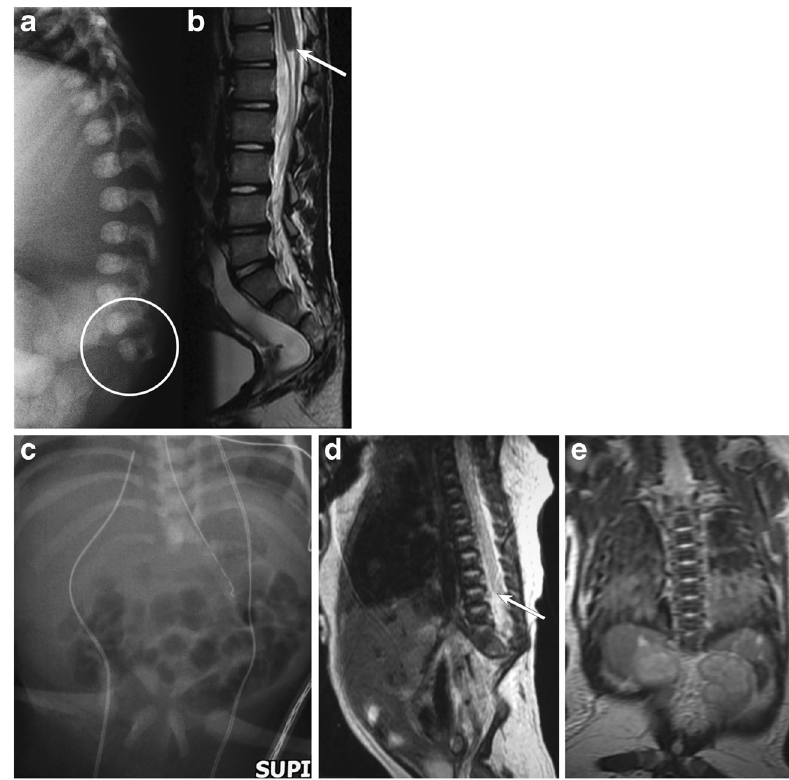
Fig. 3 a - b : Split cord/ diastematomyelia in 15 year old: Axial ( a ) and sagittal T2- weighted ( b ) MR images of the lumbar spine reveals an osseous septum ( thin arrow on a ) dividing the spinal cord into symmet- ric halves ( thick, block arrows on a ). Notice that the cord is low- lying and posteriorly positioned within the spinal canal ( thin arrow on b ) and contains a syrinx ( block arrow on b ). Associated dural ectasia ( star on b ) is also